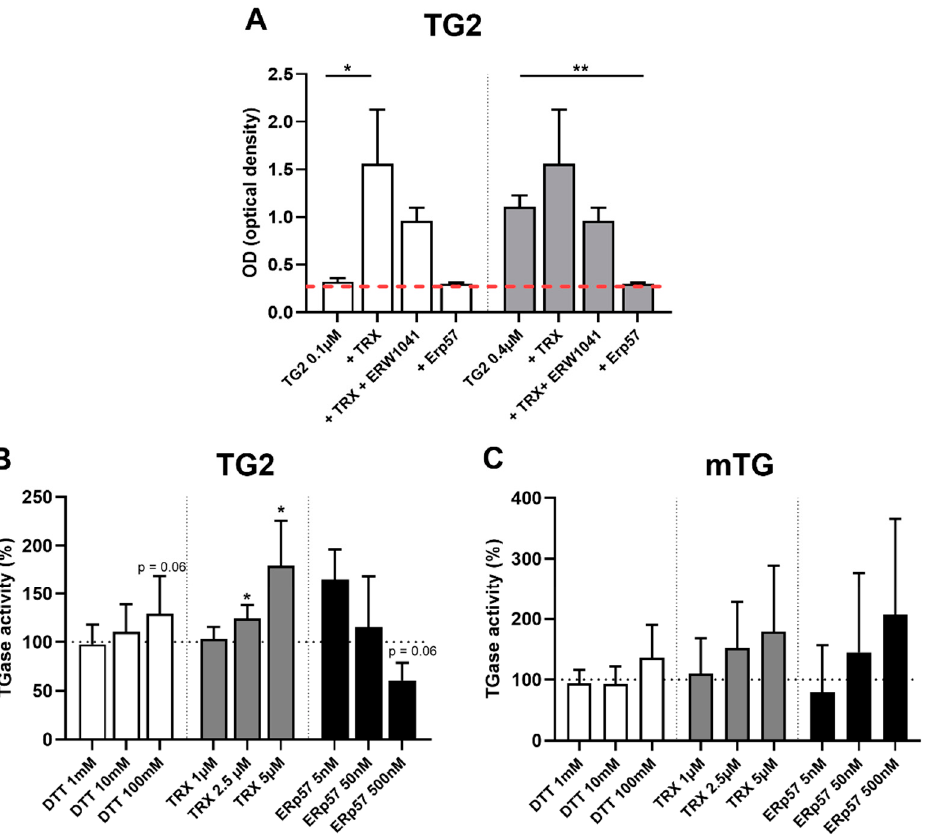
Figure 3. Oxidoreductive regulation of transglutaminase 2 (TG2) by endogenous thioredoxin-1 (TRX) and ERp57. ( A ) Two different doses of TG2 were immobilized onto fibronectin-coated 96 well plates. Significant stimulation of low levels of TG2 (0.1 µ M) by TRX. Coincubation with ERW1041 at 200-fold molar excess reduced this effect by trend. At higher doses of TG2 (0.4 µ M), stimulation by TRX (4 µ M) was less pronounced, but enzymatic activity could be reduced up to the background level via oxidation by ERp57. ( B ) 0.1 µ M TG2 was immobilized onto tissue culture-treated 96 well plates. Reduction by dithiothreitol (DTT) resulted in a slightly, not statistically significant enhanced TG2 activity. TRX significantly raised TG2 activity in a dose-dependent manner. Oxidation of TG2 by ERp57 trended to reduce TG2 activity. ( C ) mTG activity was not significantly influenced by DTT, TRX and ERp57. B) Red line = background signal. B/C) Black dashed line = control condition. Data are shown as mean ± standard deviation. * p < 0.05, ** p < 0.01.